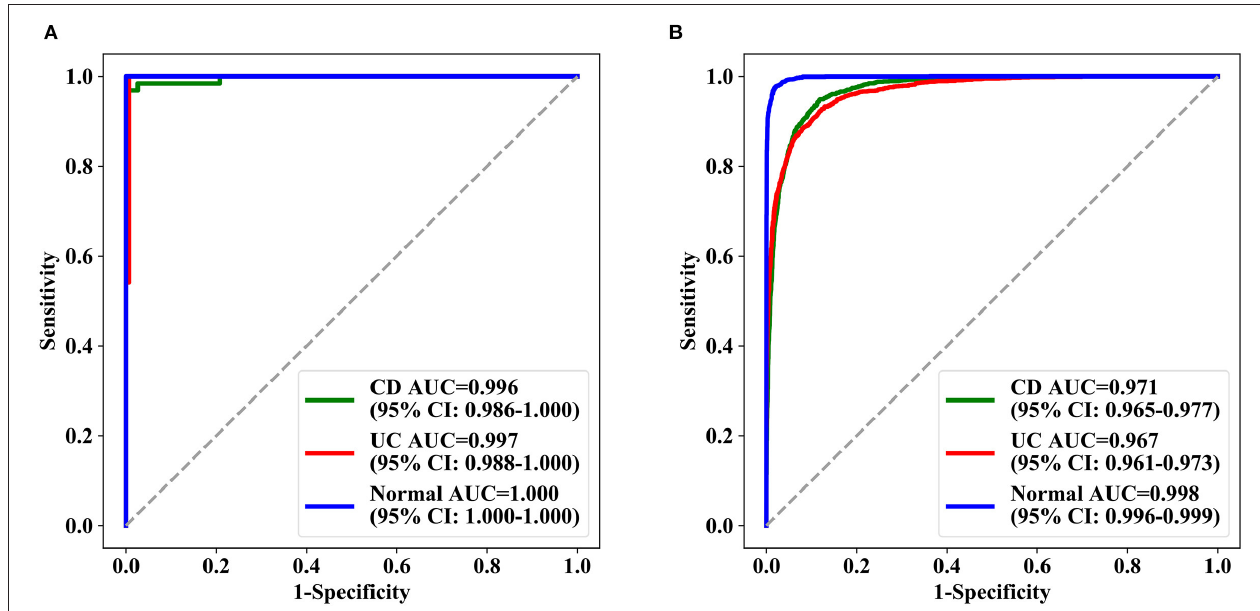
FIGURE 3 | ROC curves achieved by deep model ROC of the three categories of deep learning model in the test set. (A) The test results of three groups of patients and (B) the test results of the lesions (signal picture). AUC represents the area under the ROC curve, and in parentheses is the 95% confidence interval of AUC. AUC, the area under the receiver operating characteristic curve; ROC, receiver operating